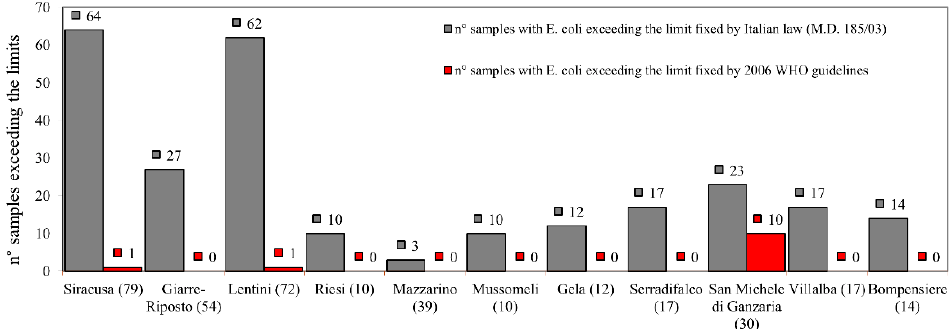
Figure 5. Percentage (%) of samples with E. coli concentration exceeding/lower than the limit fixed by the Italian law (M.D. 185/03) [9] ( left ) and by 2006 WHO guidelines [10] ( right ) for the selected WWTPs in Sicily. WWTPs in decreasing PE order and with the number of total samples in brackets.